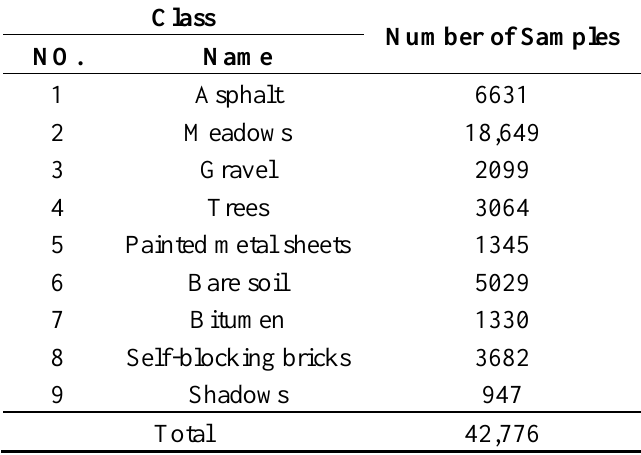
Table 1. Labeled samples for the University of Pavia dataset.